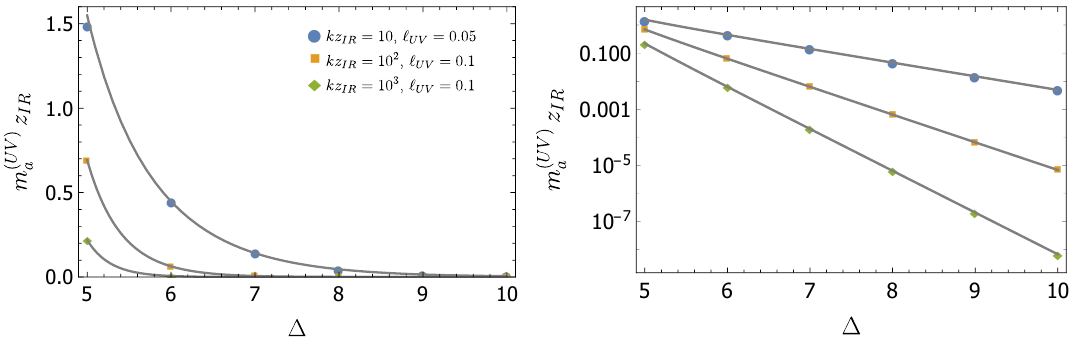
), with kz UV = 1, (cid:27) 0 = 0 : 1 and IR p k =